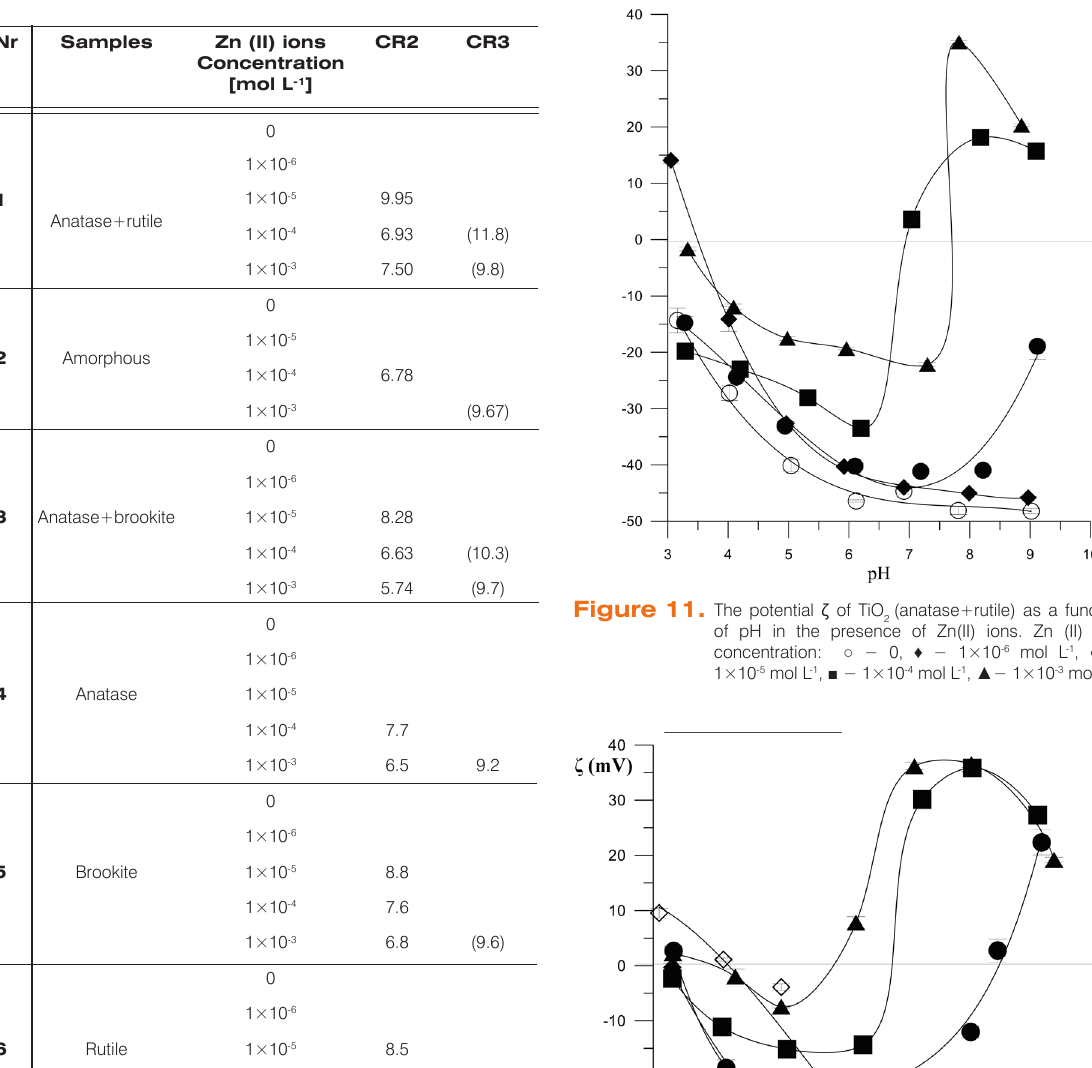
Table 6. The values of charge reversal points for TiO